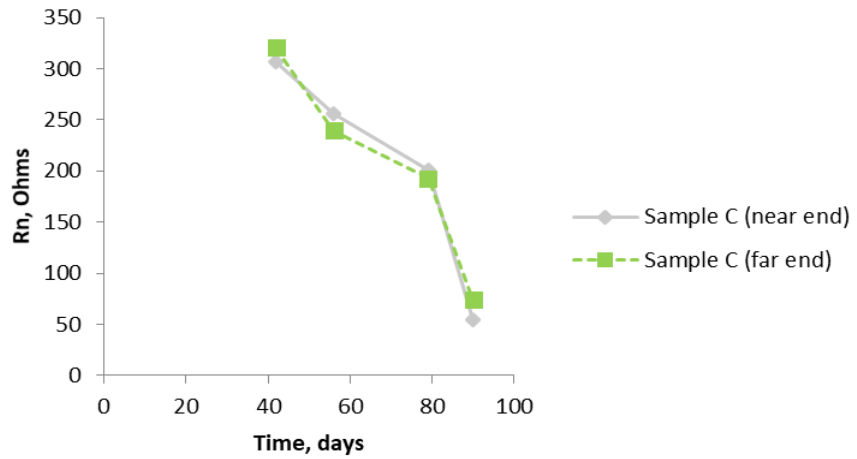
Figure 10. R n results for Sample B (near end 4% Cl, far end 0% chloride) using the bridge arrange- ment.